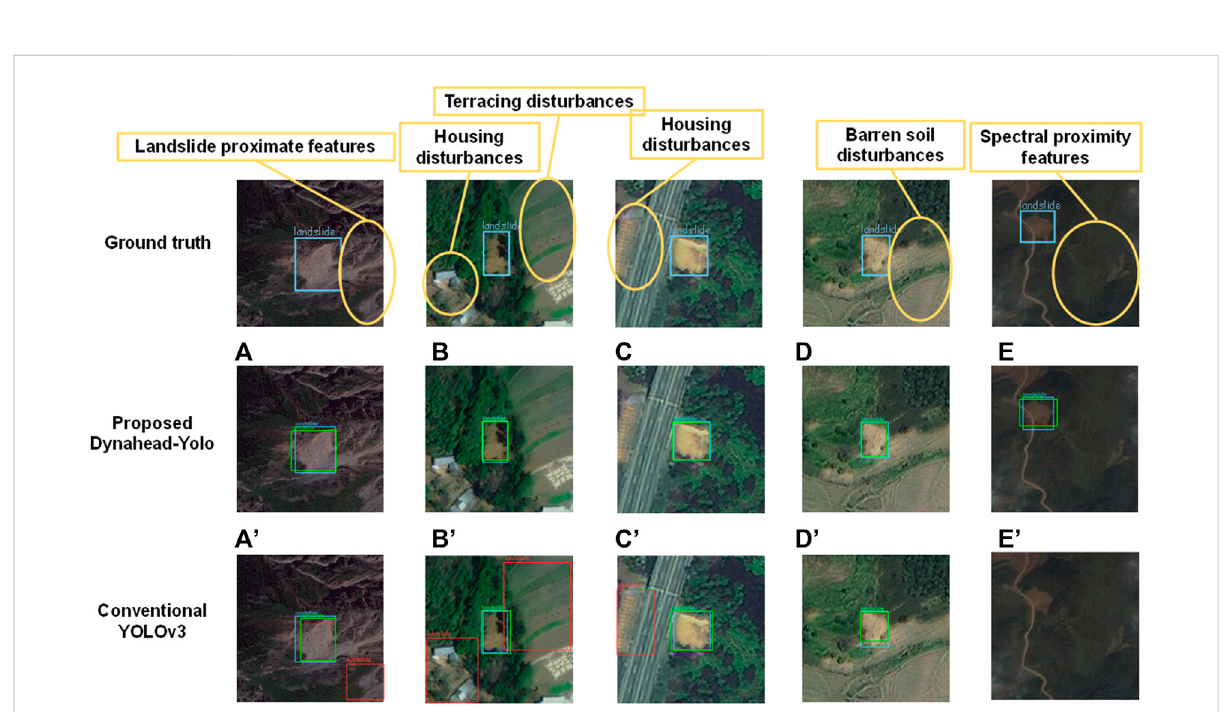
FIGURE 5 Complex background landslide detection. A – E show the landslide detection results of Dynahead-Yolo with different complex backgrounds. A 9 – E 9 represent the detection results of YOLO v3 in the corresponding complex